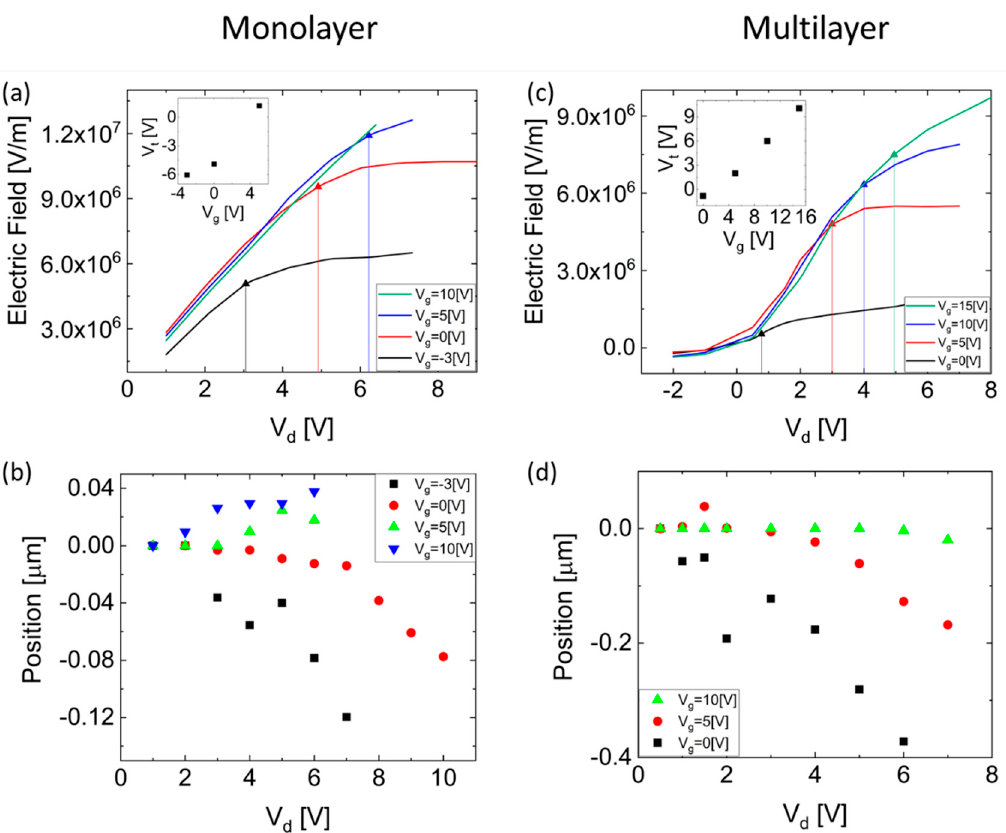
Figure 3. ( a ) The electric field at the Au–MoS 2 interface near the source electrode as a function of the drain voltage for varying gate voltages; vertical lines representing the pinch-o ff voltages for the di ff erent bias conditions are also presented. The inset shows the threshold voltage extracted for the di ff erent gate voltages in a single-layer MoS 2 transistor. ( b ) Pinch-o ff position as a function of the drain voltage extracted for varying gate voltages in a single-layer MoS 2 transistor. ( c , d ) are similar to ( a , b ), respectively, for a few-layer MoS 2